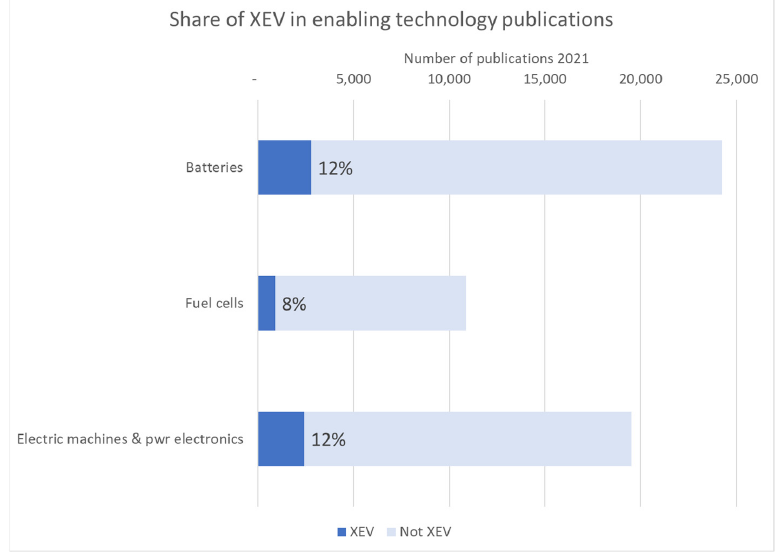
Figure 5. Overlap between XEV and enabling technology publications (2021).